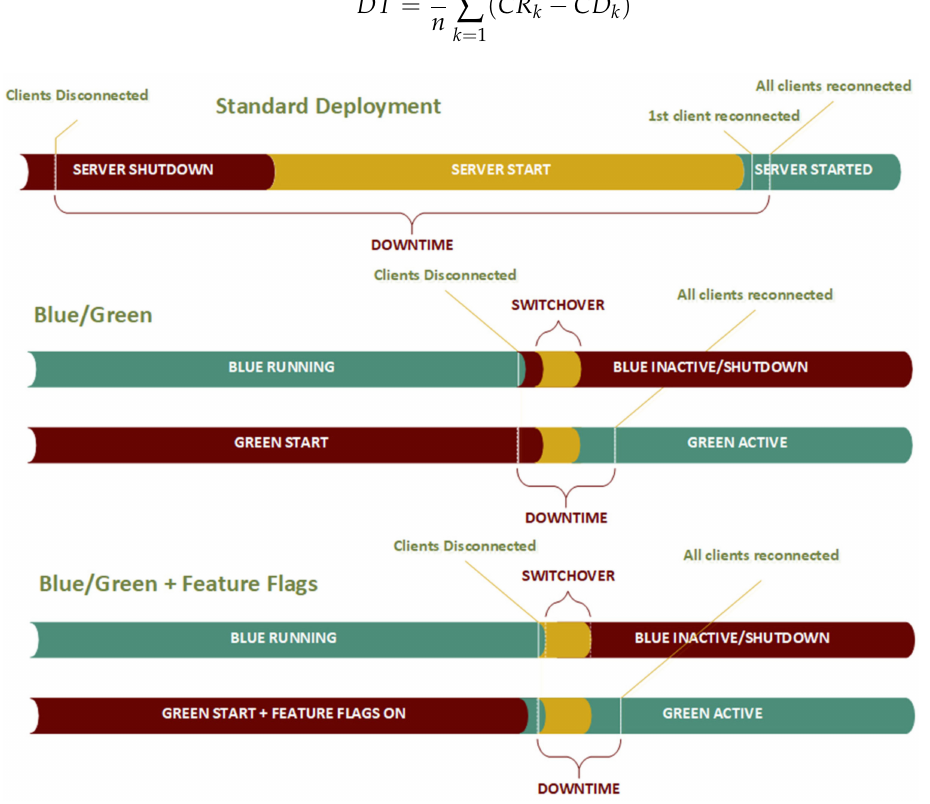
Figure 10. Comparison of server node restart process with the standard approach, blue/green and blue/green with feature